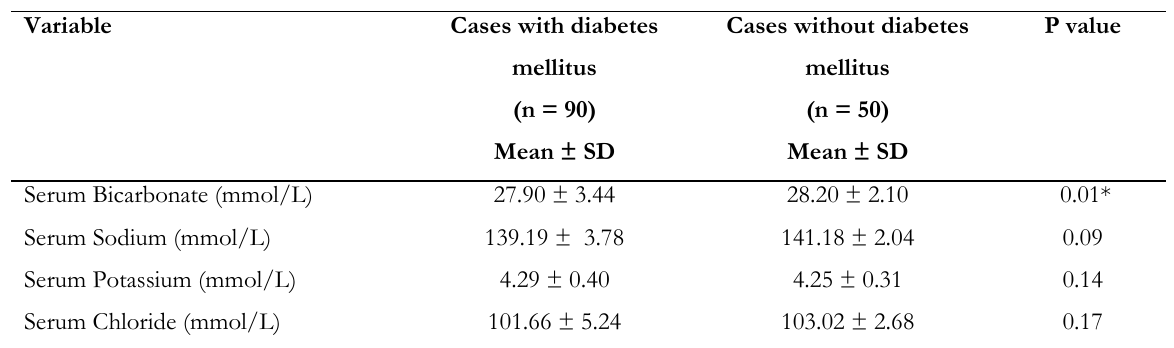
Table 3 Electrolyte levels in the study population (n=140)